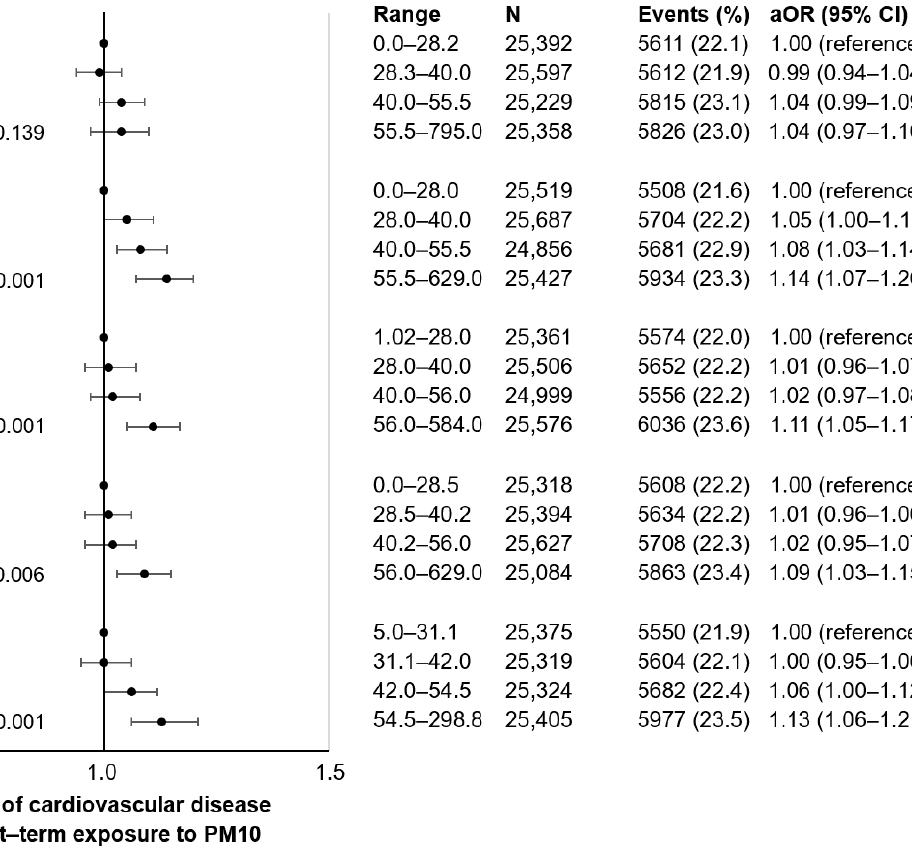
Figure 1. Association of short-term exposure to PM10 with cardiovascular disease events among 5-year cancer survivors. Adjusted odds ratio calculated by conditional logistic regression after adjustment for mean daily temperature (categorical, 1st, 2nd, 3rd, and 4th quartiles). Acronyms: N, number of participants; aOR, adjusted odds ratio; CI, confidence interval; PM, particulate matter.